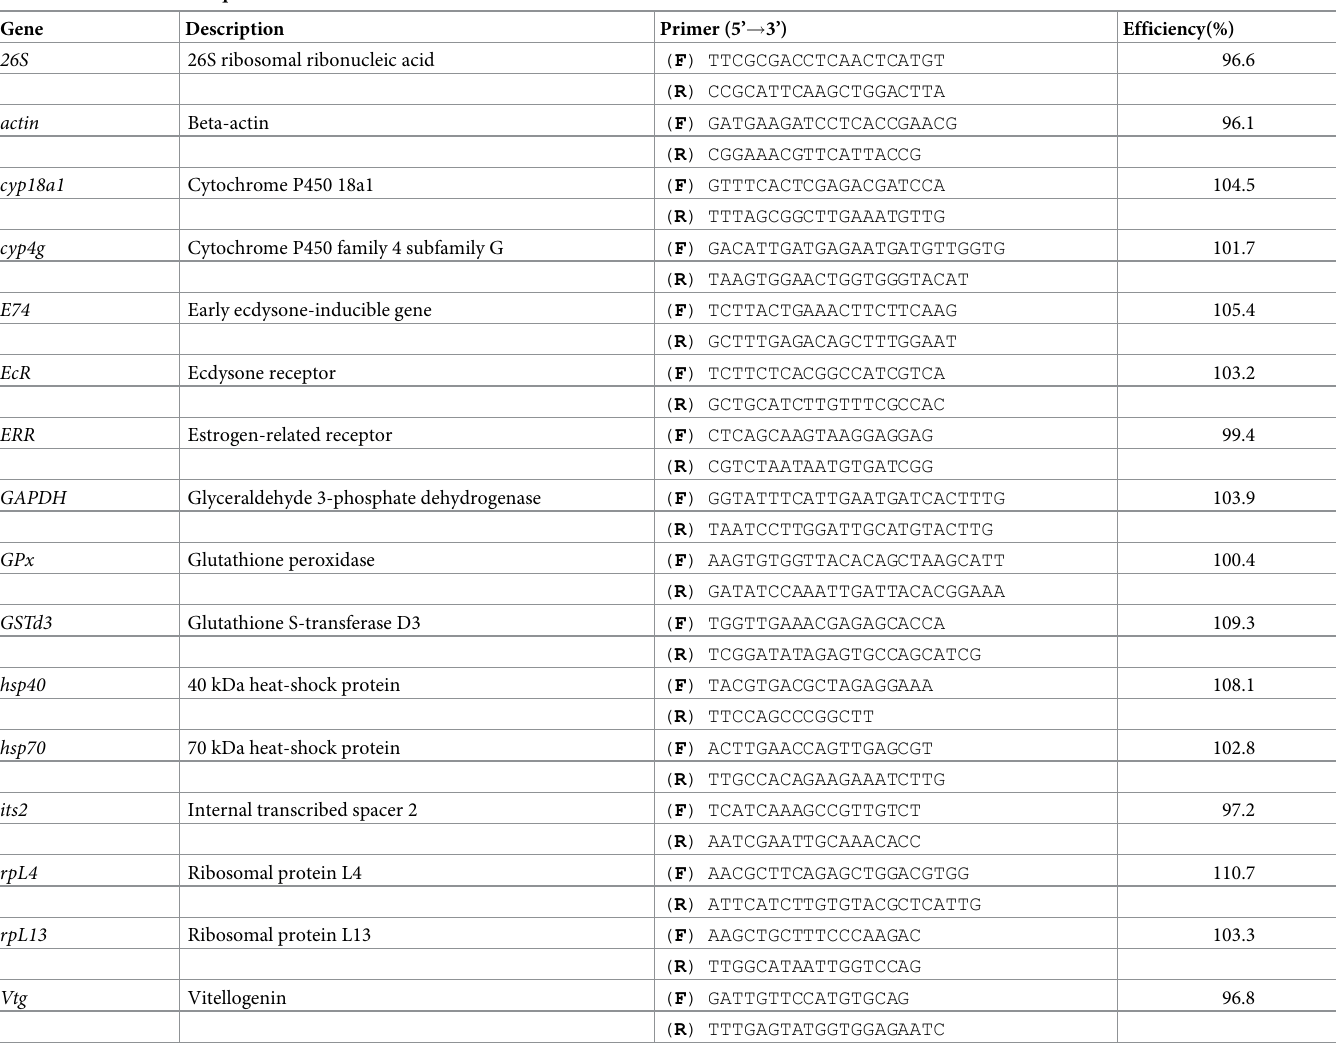
Table 1. Primers used for quantitative real-time RT-PCR.